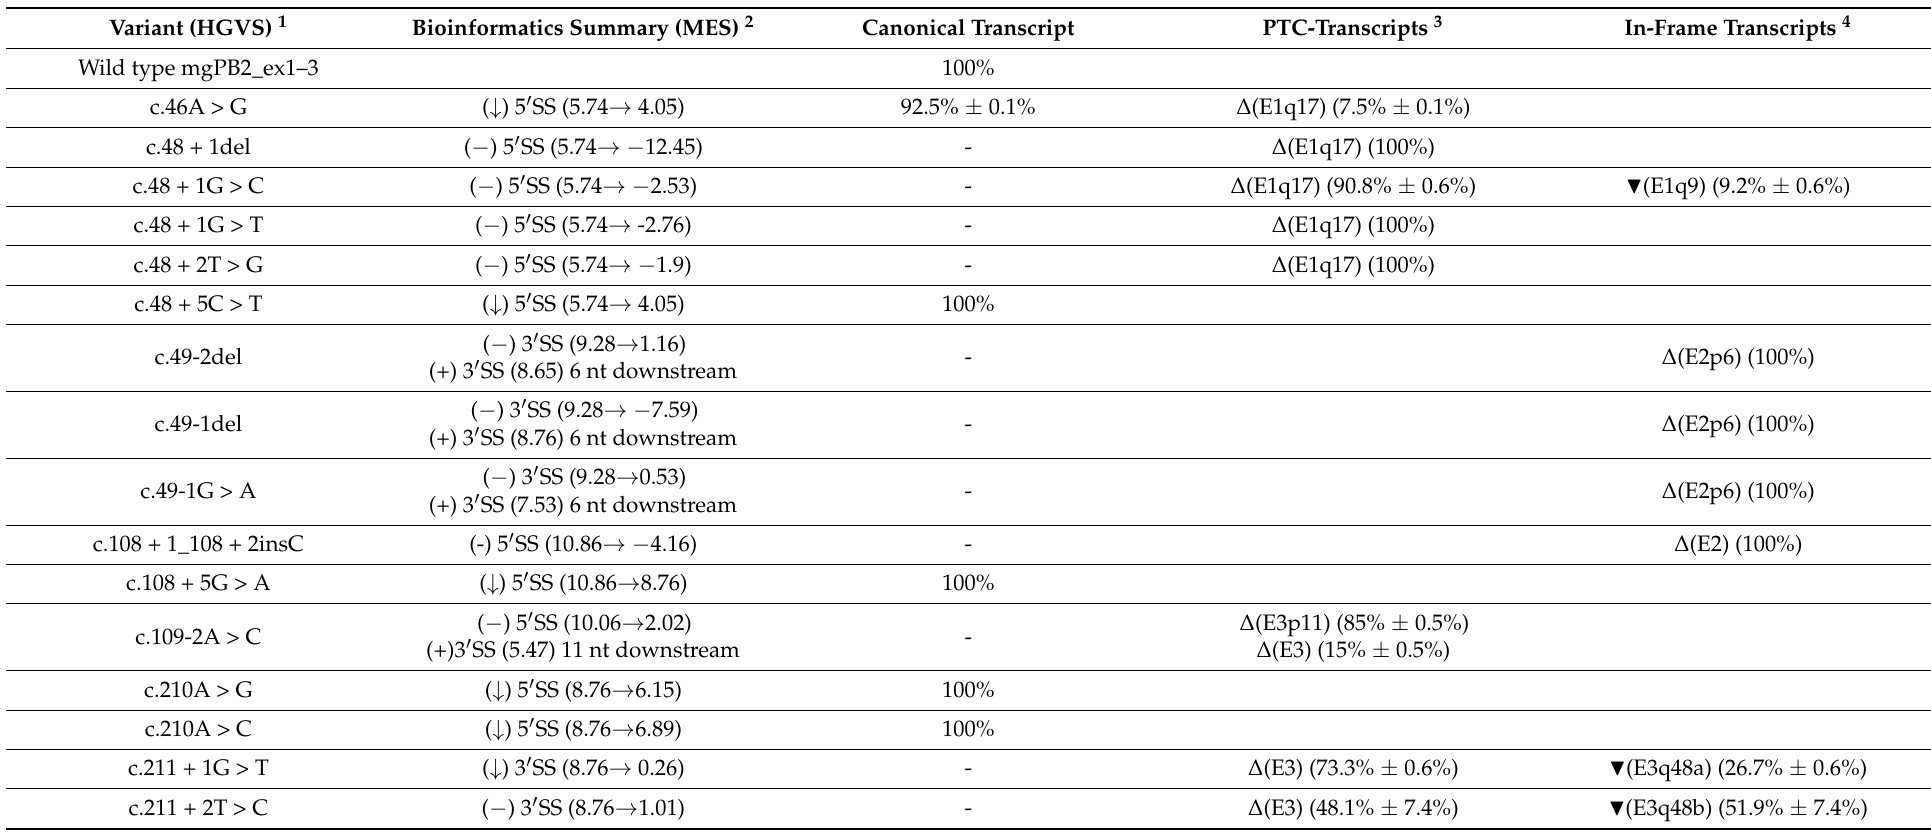
Table 4. Splicing outcomes of PALB2